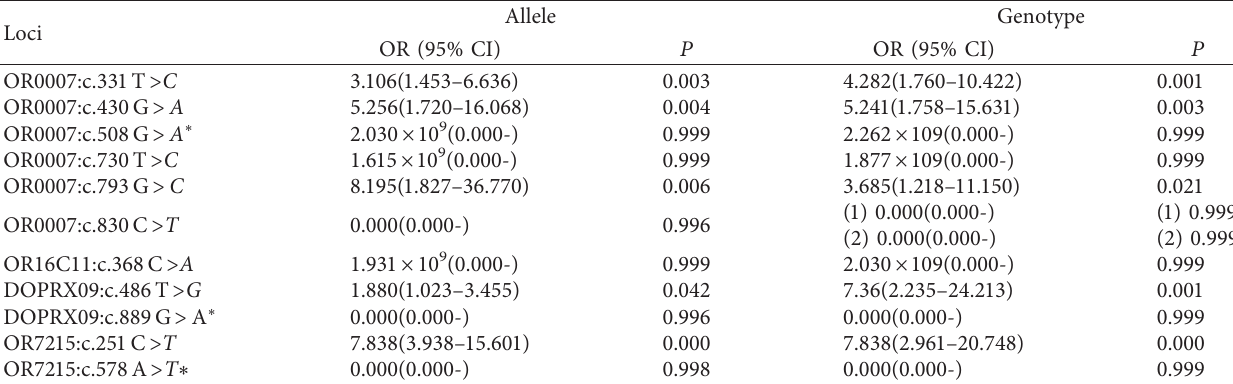
Table 4: Logistic regression analysis of alleles and genotypes between sniffer dogs and guide dogs. Allele Loci OR (95% CI)